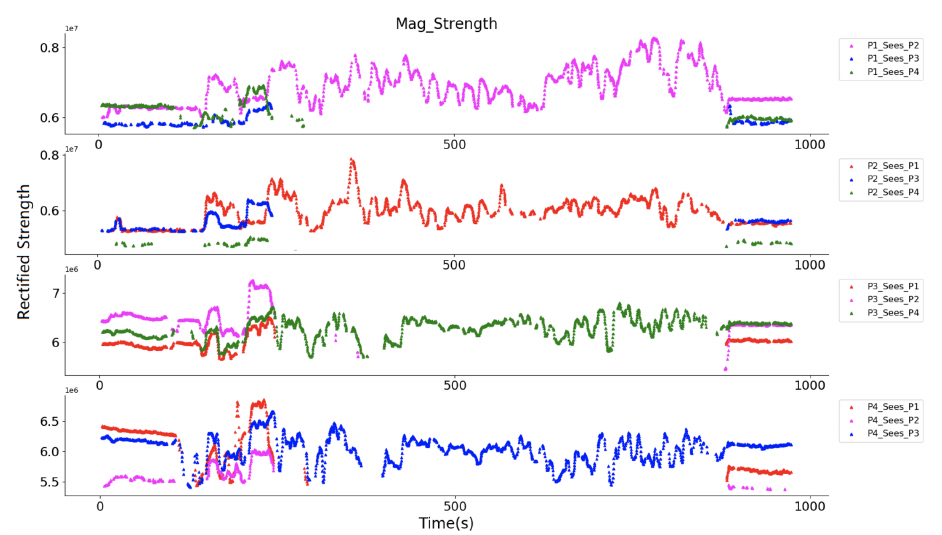
Figure 22. Perceived magnetic field strength of each prototype in the whole